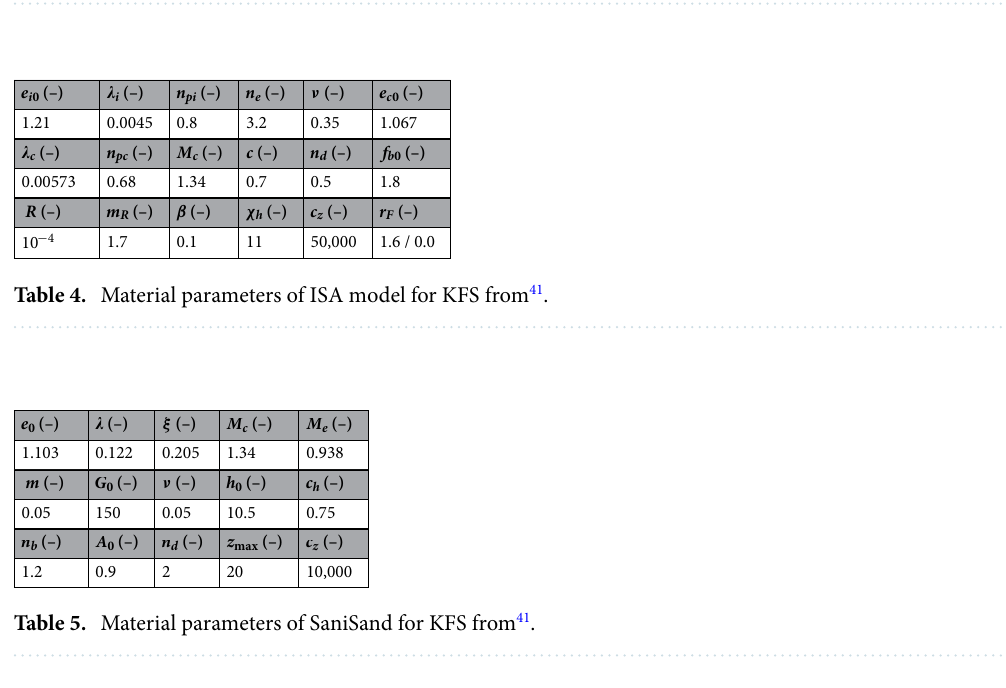
Table 3. Material parameters of Hypo+IGS for KFS from 41 .